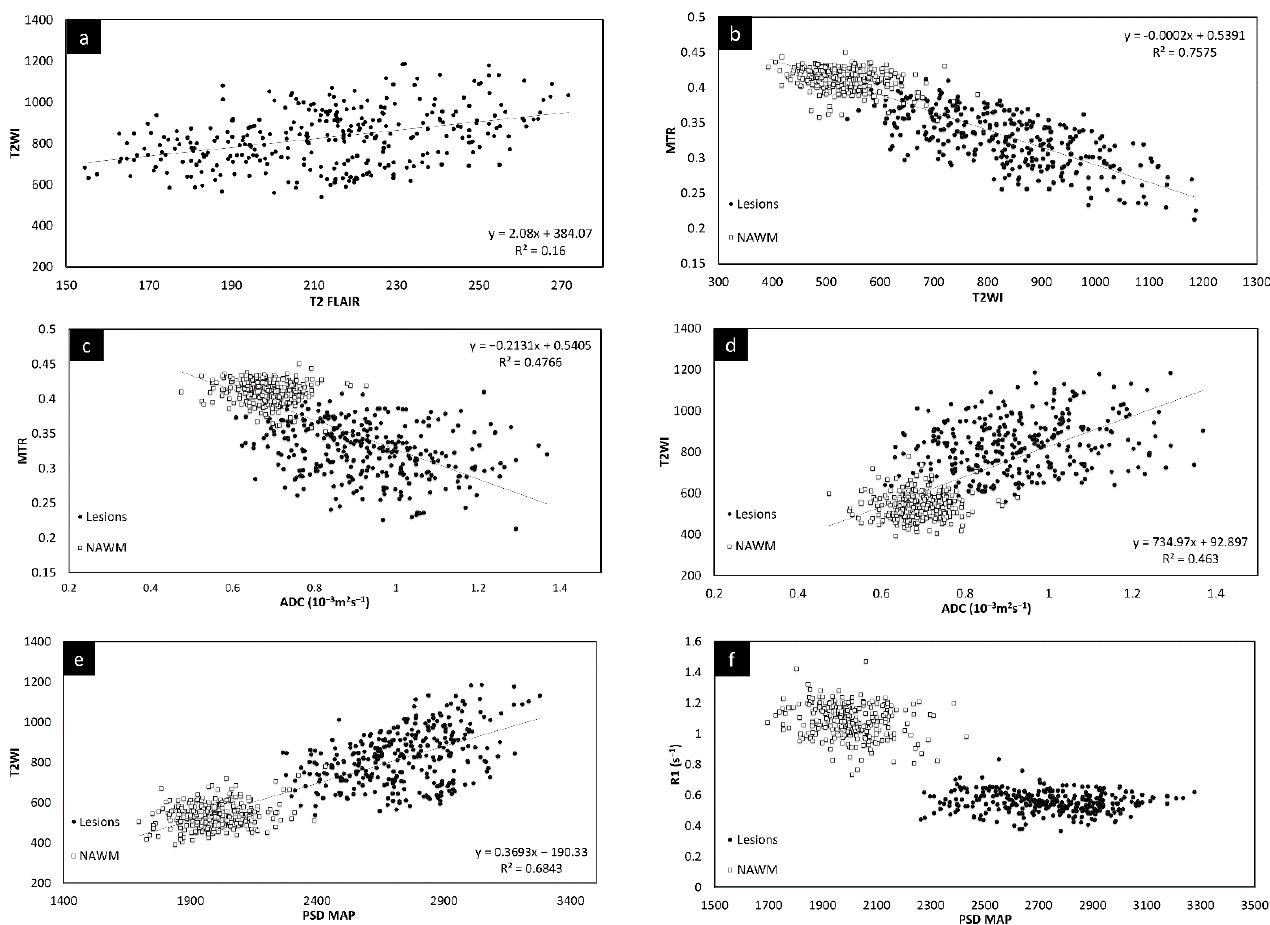
Figure 3. Signal intensity of T2WI versus T2 FLAIR lesions averaged across both time points ( a ). There is a linear relationship between the two modalities. Signal intensity of T2WI versus MTR lesions and NAWM averaged across both time points ( b ). The plots show that the signal intensity of the MTR data correlates with T2WI data suggesting that water content is the key driver to these changes in both measures. MTR plotted against ADC averaged across both time points ( c ). MS lesions have a significant drop in MTR and increase in ADC. T2WI signal intensity versus ADC averaged across both time points ( d ) showing lesions have a significant increase in signal for both T2WI and in ADC. T2WI signal intensity versus PSDMAP averaged across the two different time points ( e ) showing lesions have a significant increase in signal in both T2WI and in spin density. This shows they are both sensitive to the amount of water present in the tissue. Signal intensity of the R1 map ( f ) versus PSDMAP averaged across the two different time points shows a clear separation of healthy controls and MS subjects.